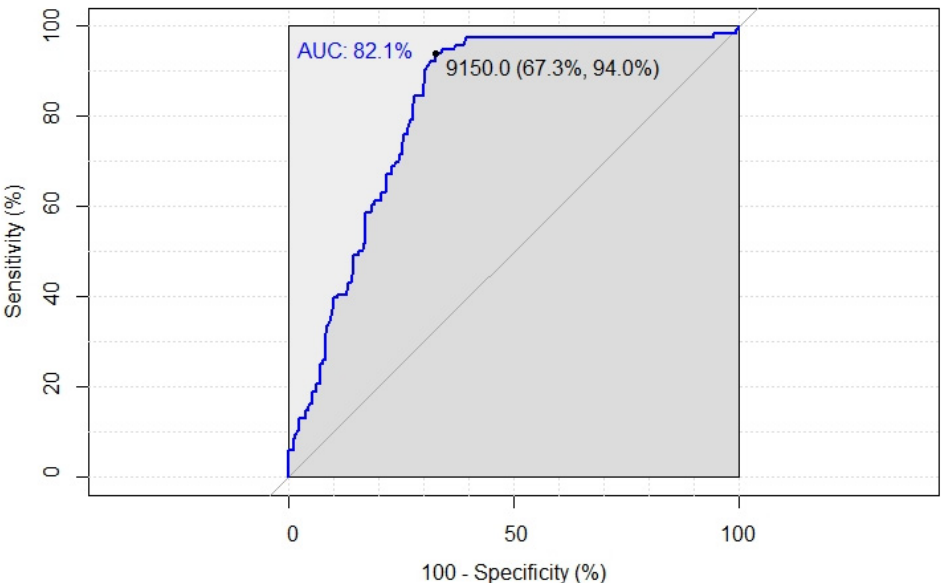
Figure 1. ROC curve. The new cut-off of cytokeratin 19 mRNA copy number was obtained by ROC curve. Positive and negative predictive values of this new cut-off were 61.2% and 95.3%, respectively.